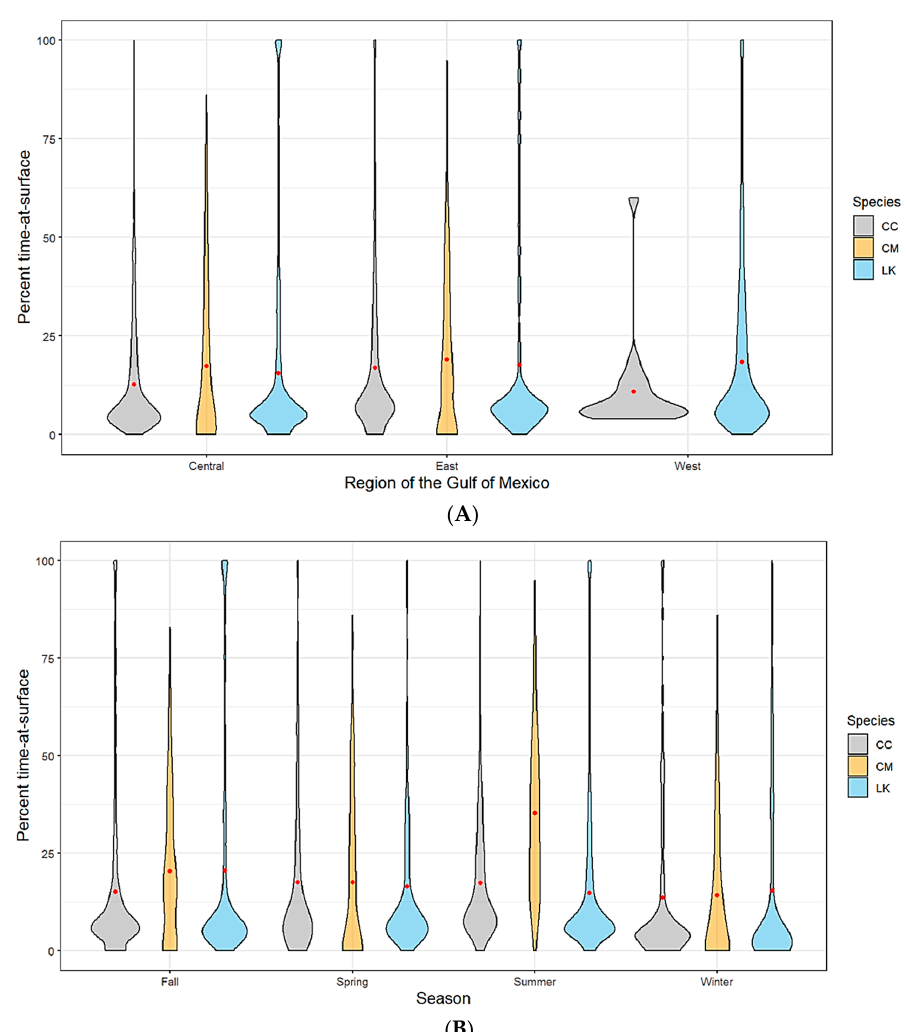
Figure 2. ( A ) Spatially (region of the Gulf of Mexico) and ( B ) seasonally delineated time-at-surface summaries by species (CC—loggerhead turtles; CM—green turtles; LK—Kemp’s ridley turtles). A violin plot is used to show the distribution shape of the data with wider sections indicating a higher frequency. The red dot within each shape represents the mean.